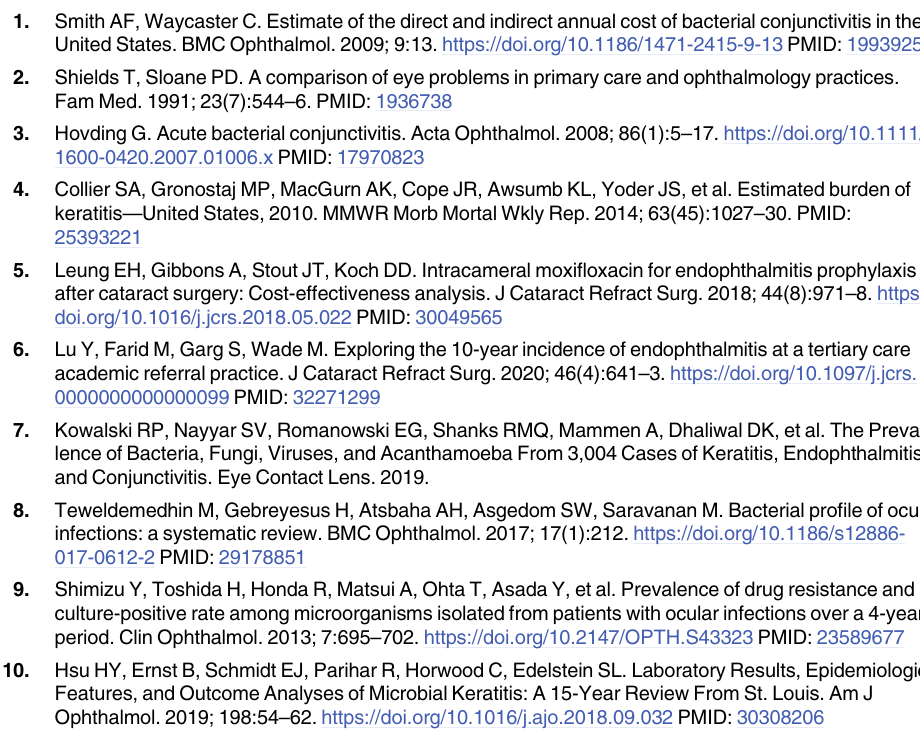
S3 Table. Class, gene identity, function, and reference genome of the 235 Staphylococcus aureus virulence factor database. S4 Table. Virulence factors associated with one or more strain groups